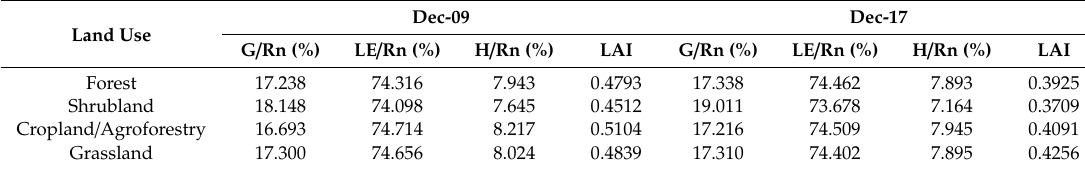
Table 4. Partitioning of net radiation to energy balance components.